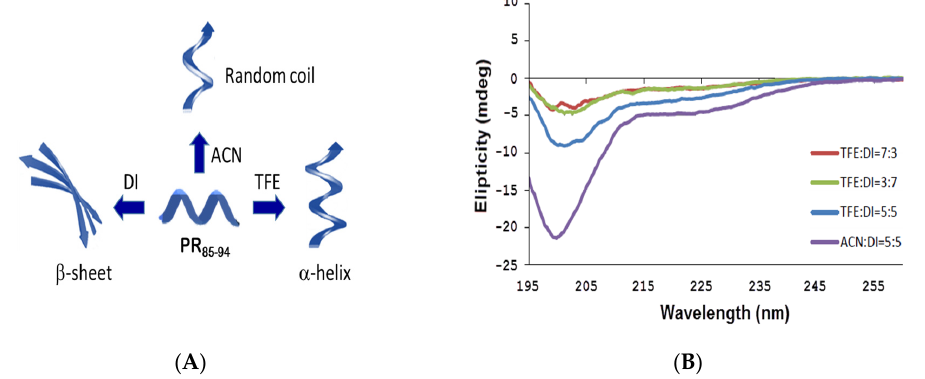
Figure 2. ( A ) Effects of organic solvents on protein secondary structure and function. ( B ) Circular dichroism (CD) spectra of the HIV PR 85–94 peptides and their respective complexes on selective solvents. TFE, 2,2,2-trifluorethanol; DI, deionized water; ACN,